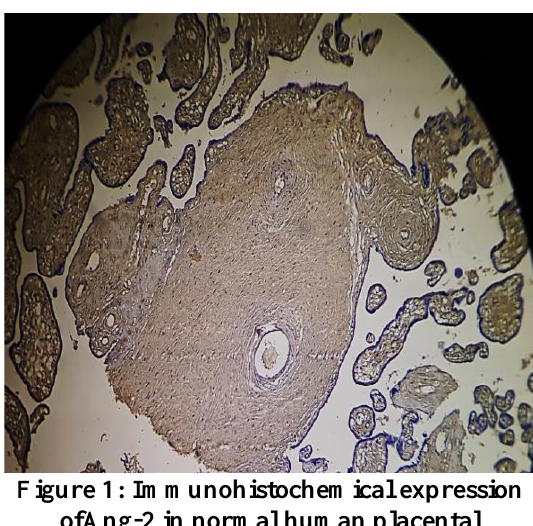
Figure 1: Immunohistochemical expression ofAng-2 in normal human placental